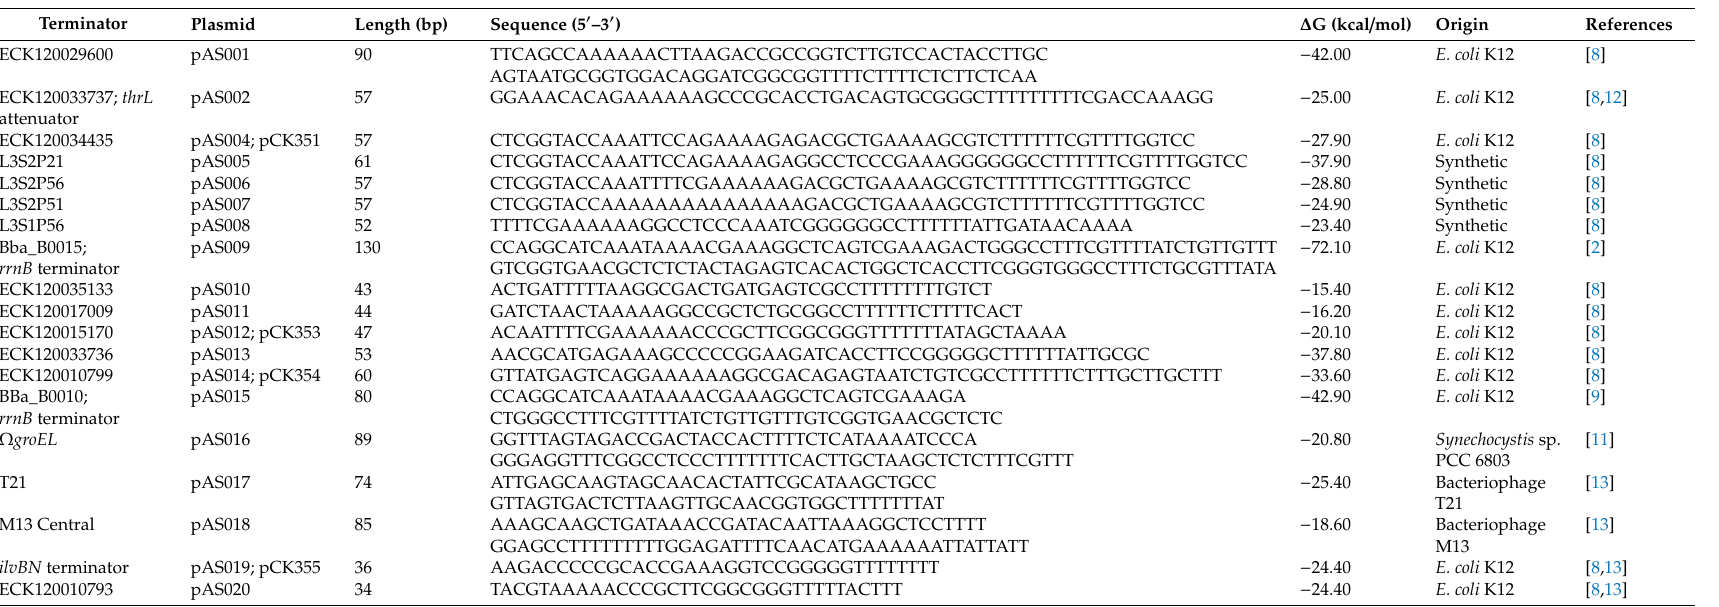
Table 1. Terminators used in this